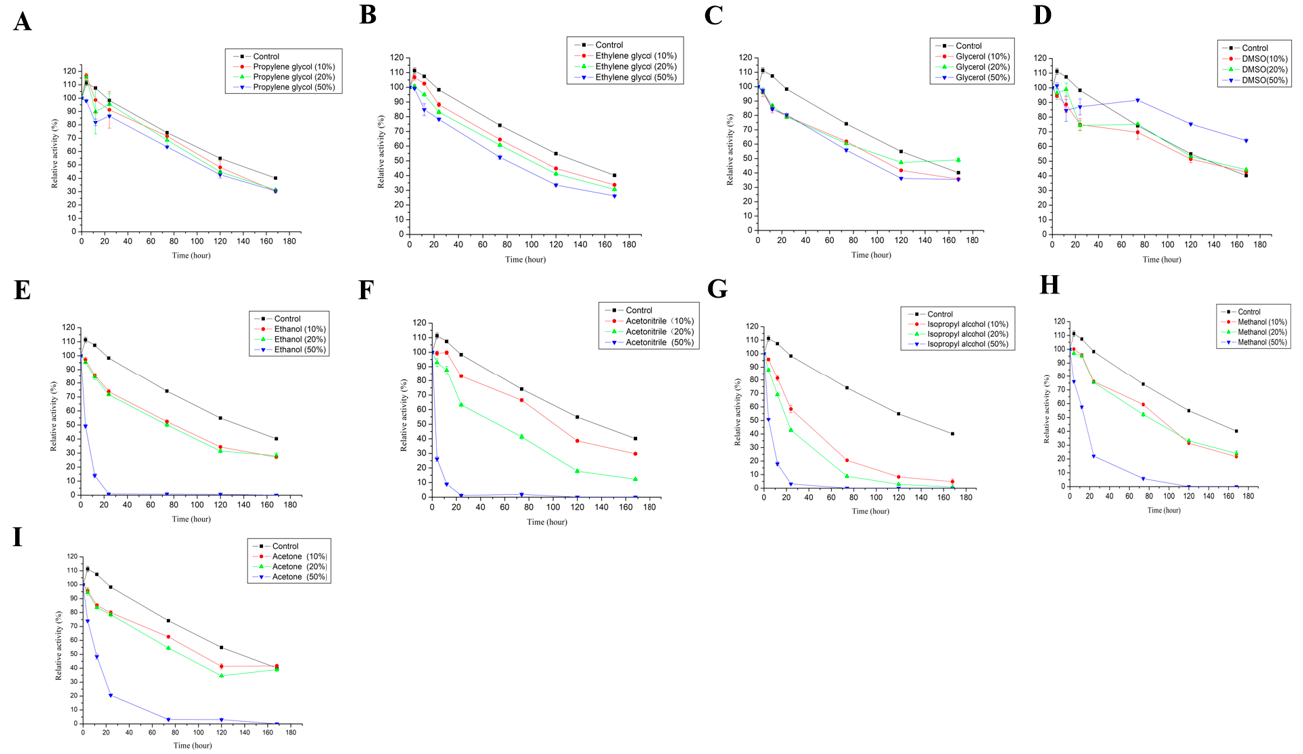
Figure 5. Effects of different organic solvents on the stability of LAC-4 laccase. ( A ) Propylene glycol ( B ) Ethylene glycol ( C ) Glycerol ( D ) DMSO ( E ) Ethanol ( F ) Acetonitrile ( G ) Isopropyl alcohol ( H ) Methanol ( I ) Acetone. Control, no addition of any organic solvent.